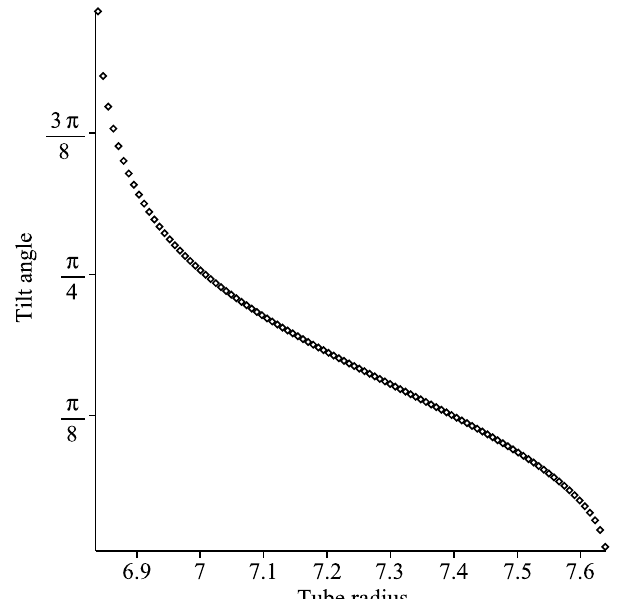
Figure 10. Graph showing optimal tilt angle of coronene molecule as tube radius varies.